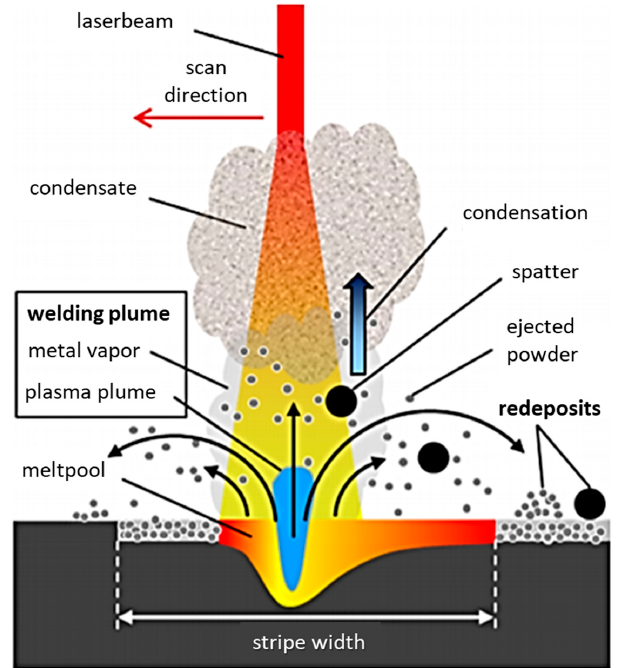
Figure 2. Schematics of LPBF process by-products formation. Adapted from Reference [97] with permission from Elsevier.